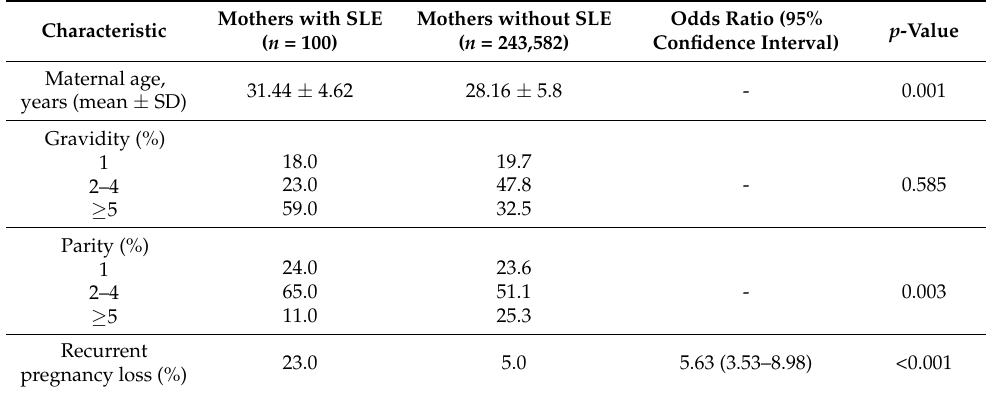
Table 1. Demographic and clinical characteristics of mothers with and without SLE.